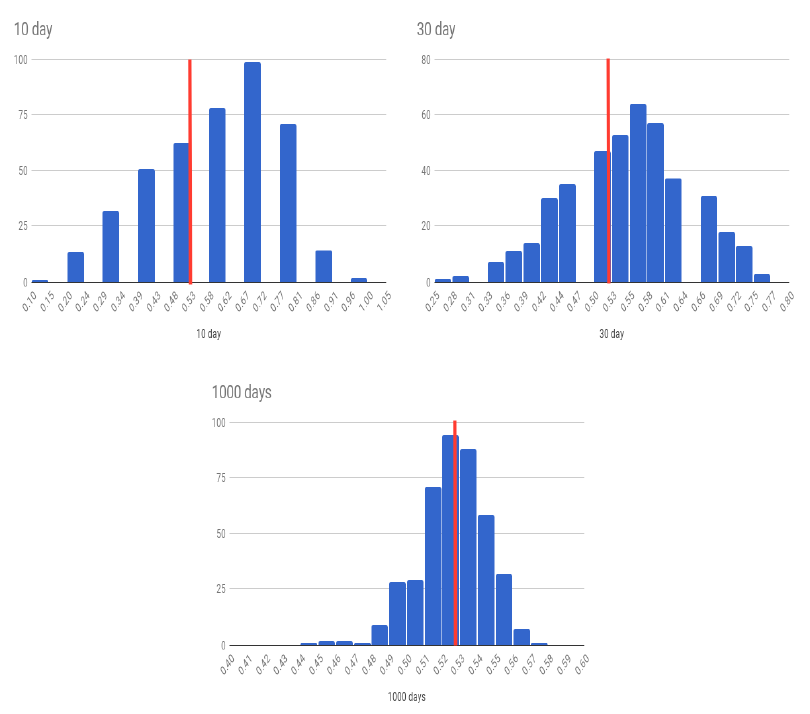
Figure 10. Histograms of the results from all experiments, where the test data was for the Stationary out-of-sample experiment (case OS). The three plots are the cases when F = 10, 30, 1000 days, respectively. The red line is at the 52.7% accuracy cut off.